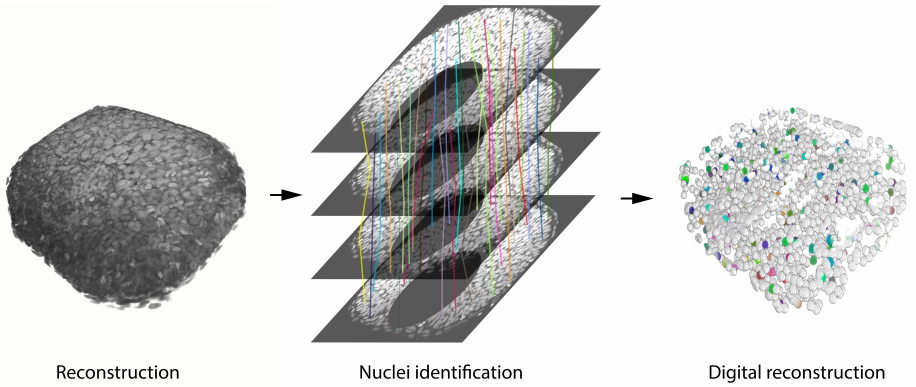
Figure 4. Schematic representation of the pipeline followed to reconstruct objects in three-dimensional images by OSCAR. ( Left ): 3D representation of the original image (FIJI-3D Viewer). ( Center ): representation of how neighboring sections from the same 3D object are connected. Each colored line follows the trajectory of a given nucleus along the z -axis. ( Right ): 3D representation of the reconstructed 3D image. Colored objects represent the nuclei that correspond to the colored lines in the central panel. A processing and segmentation pipeline is applied to the original image in order to obtain a more reliable reconstruction (Gaussian blur sigma = 20 pix; Minimum filter sigma = 20 pix; Maximum filter sigma = 20 pix; Image Calculator—Original image subtract filtered; Manual thresholding; Binary Open; Watershed; 3D Objects Counter; 3D Draw Shape—All 3D objects represented as 10 pix radius spheres; 3D Viewer).